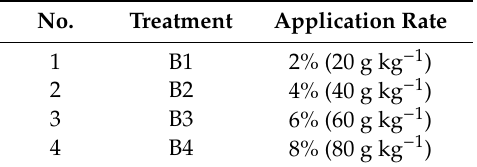
Table 4. Soil column treatments using fresh or saline